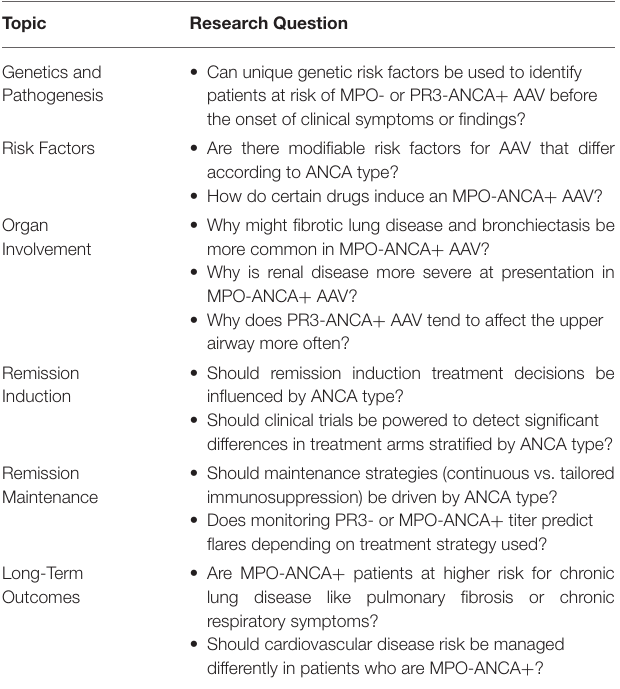
TABLE 3 | Future direction of research regarding ANCA type in AAV.